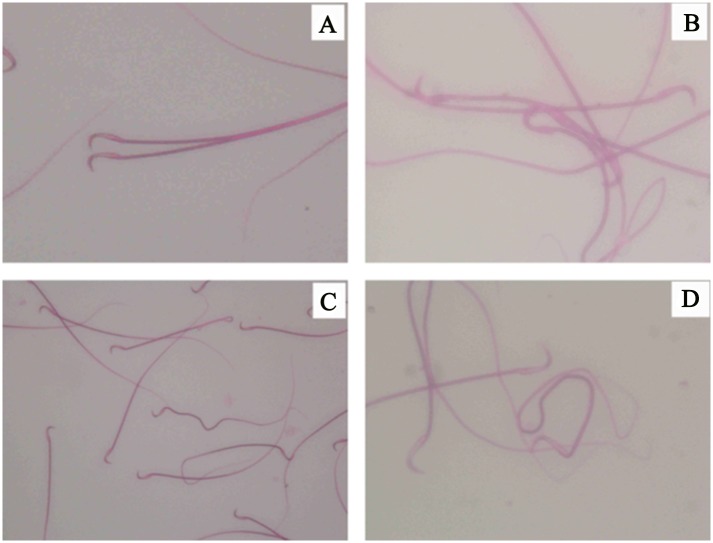
Sperm abnormality.This is illustrated by the results of the most serious damage of F1 generation of male rats’reproductive function, and with the increase of genetic algebra, damage degree showed a trend of decline. A:double head;B:head;C:curve;D:fold.